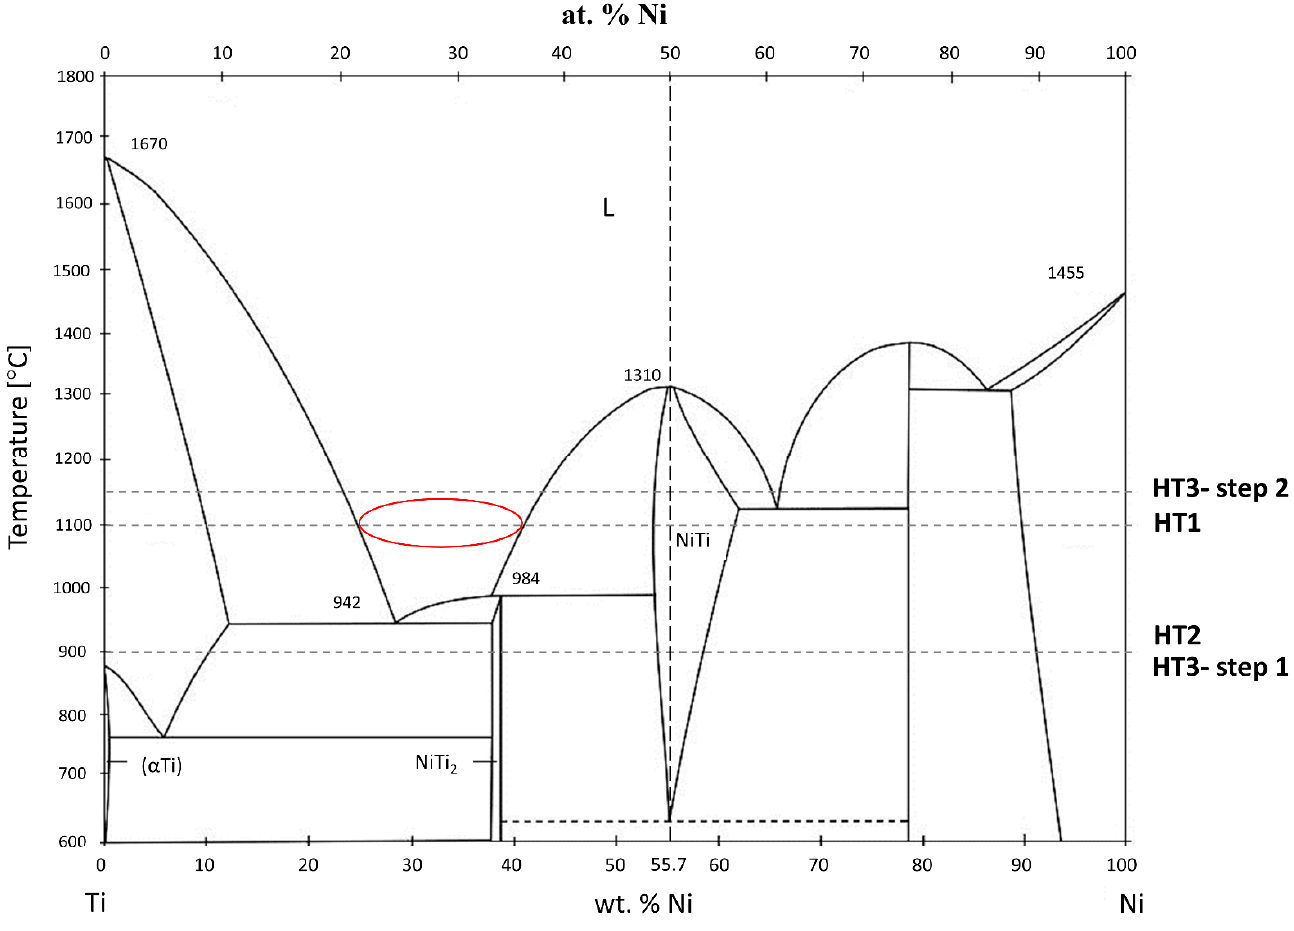
Figure 1. Phase diagram of the Ni-Ti system (based on [27]). The horizontal dashed lines represent the temperatures of the HT1–HT3 heat treatments; The vertical dashed line represents the composition of the initial Ni-Ti powder blend studied in this work; the red circle indicates the local concentrations for which there is a liquid phase at 1100 °C.